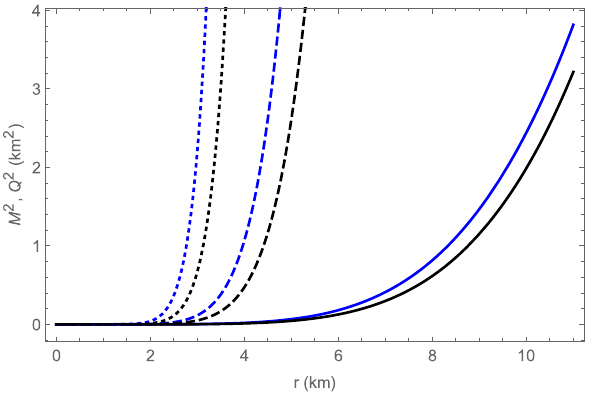
Fig. 26 Variation of mass ( M ) of compact objects with its radius ( R b ) for B surface = 82 . 11 MeV/fm 3 defined at the surface where radial pressure vanishes. Here we consider two different cases (i) at first case we take B as constant and (ii) a density dependence of B is considered in accordance with Eq. (53) where the coefficients k i are k 0 = 56 . 4636, k 1 = 0 . 02846, k 2 = 0 . 000217, k 3 = − 2 . 548 × 10 − 7 ,